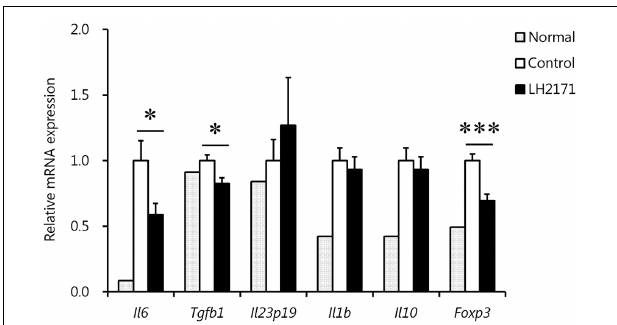
FIGURE 5 | Regulation of the expression of cytokines and transcription factors involved in Th17 differentiation in the inguinal LNs by LH2171 administration before EAE onset. The inguinal LNs were collected from normal mice and EAE mice treated with or without LH2171 on day 7, before EAE onset. Data are shown as means ± SEM (normal group, n = 2; control group, n = 12; LH2171-treated group, n = 10). LH2171-treated mice were compared with control mice by Student’s t -test ( ∗ P < 0.05, ∗∗∗ P < 0.001).